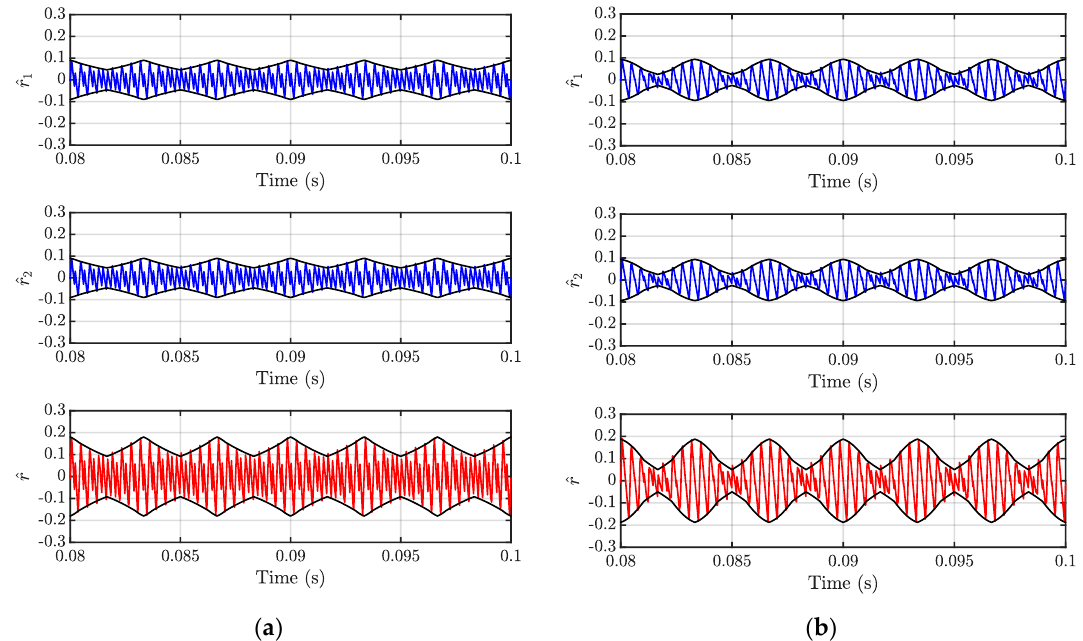
and ) (blue traces), dc-link switching 𝑟𝑟̂ 1 𝑟𝑟̂ 2